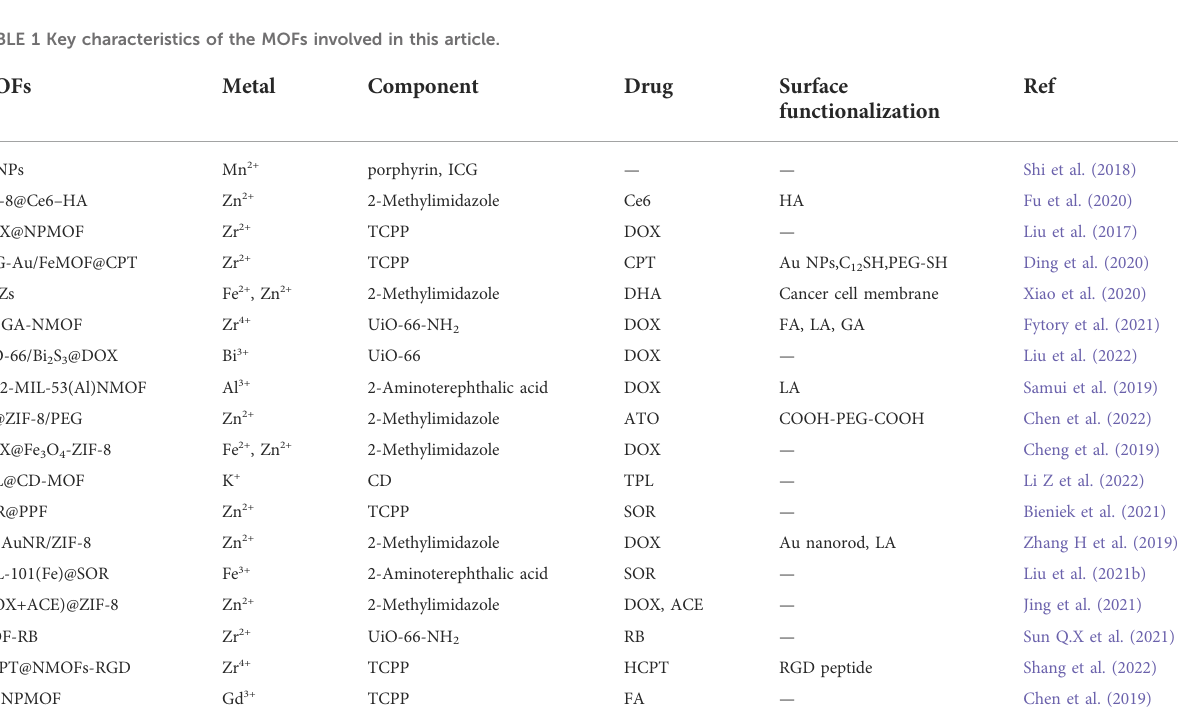
TABLE 1 Key characteristics of the MOFs involved in this